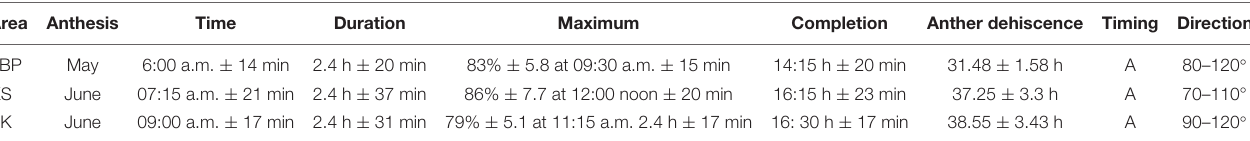
FIGURE 2 | Ordination biplot of the morphological variables at three studied sites. Directions along with the magnitudes of the variables driving each axis are also shown. TABLE 4 | Pattern of flower anthesis and anther